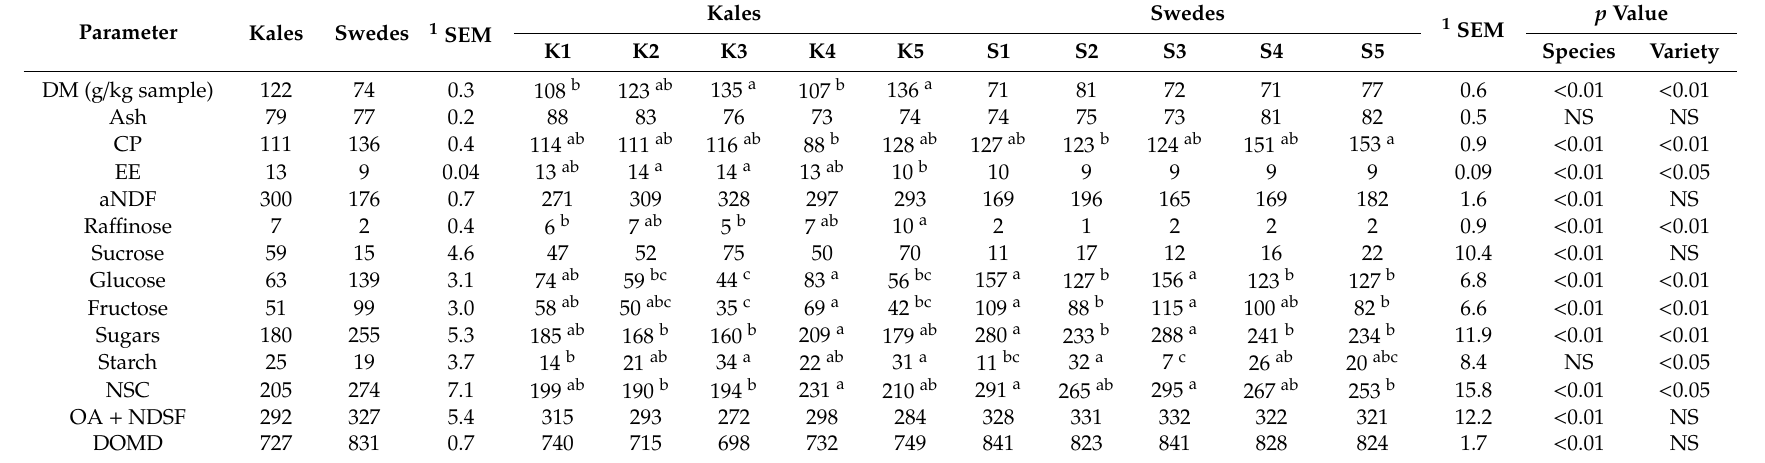
Table 1. Nutrient concentration (g / kg dry matter) of five varieties of kale (from K1 to K5) and swedes (from S1 to